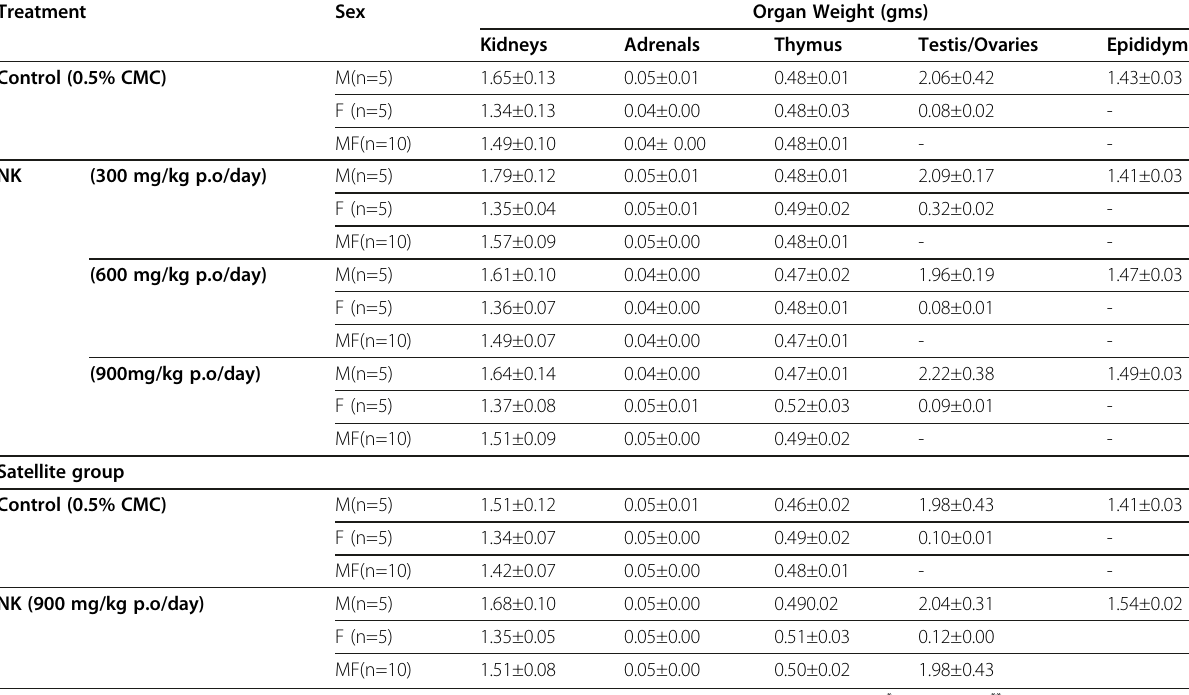
Table 10 Effect of Nuna kadugu on organ weight of experimental Sprague Dawley rats in repeated oral toxicity study Treatment Sex Organ Weight (gms) Kidneys Adrenals Thymus Testis/Ovaries Epididymis Control (0.5%